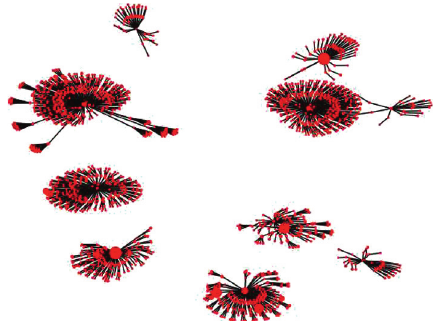
Figure 2: Asset relationships in parent asset pools.